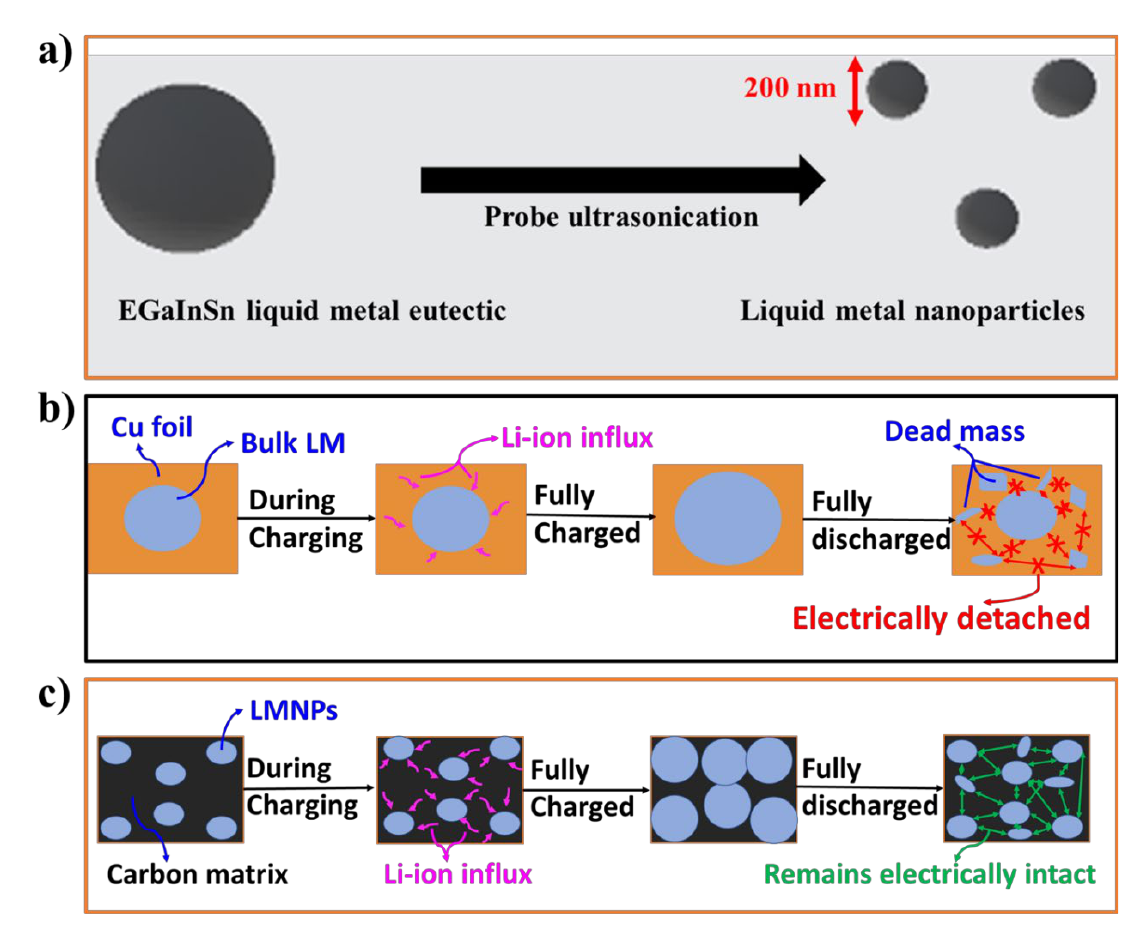
Figure 1. Schematic illustrations of ( a ) the synthesis process of EGaInSn LMNPs by probe sonication, ( b ) the delamination of typical electrodes made up of bulk liquid metal alloys, and ( c ) the self-healing property of LMNP electrodes.